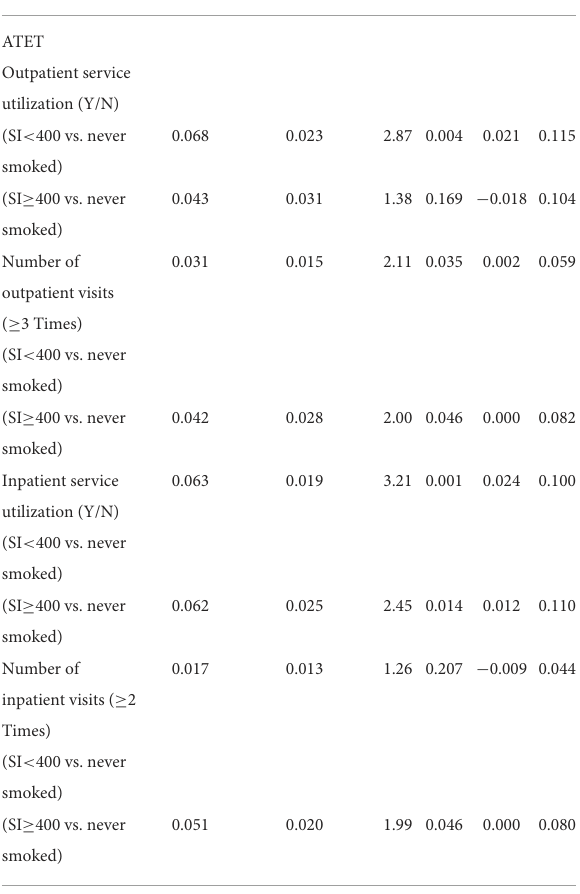
TABLE 5 Estimated ATET of smoking on outpatient service utilization TABLE 6 Effect of smoking on outpatient service utilization and and inpatient service utilization. inpatient service utilization among different age groups. N Margin Unconditional z P > z [95% Cl] Std. Err.